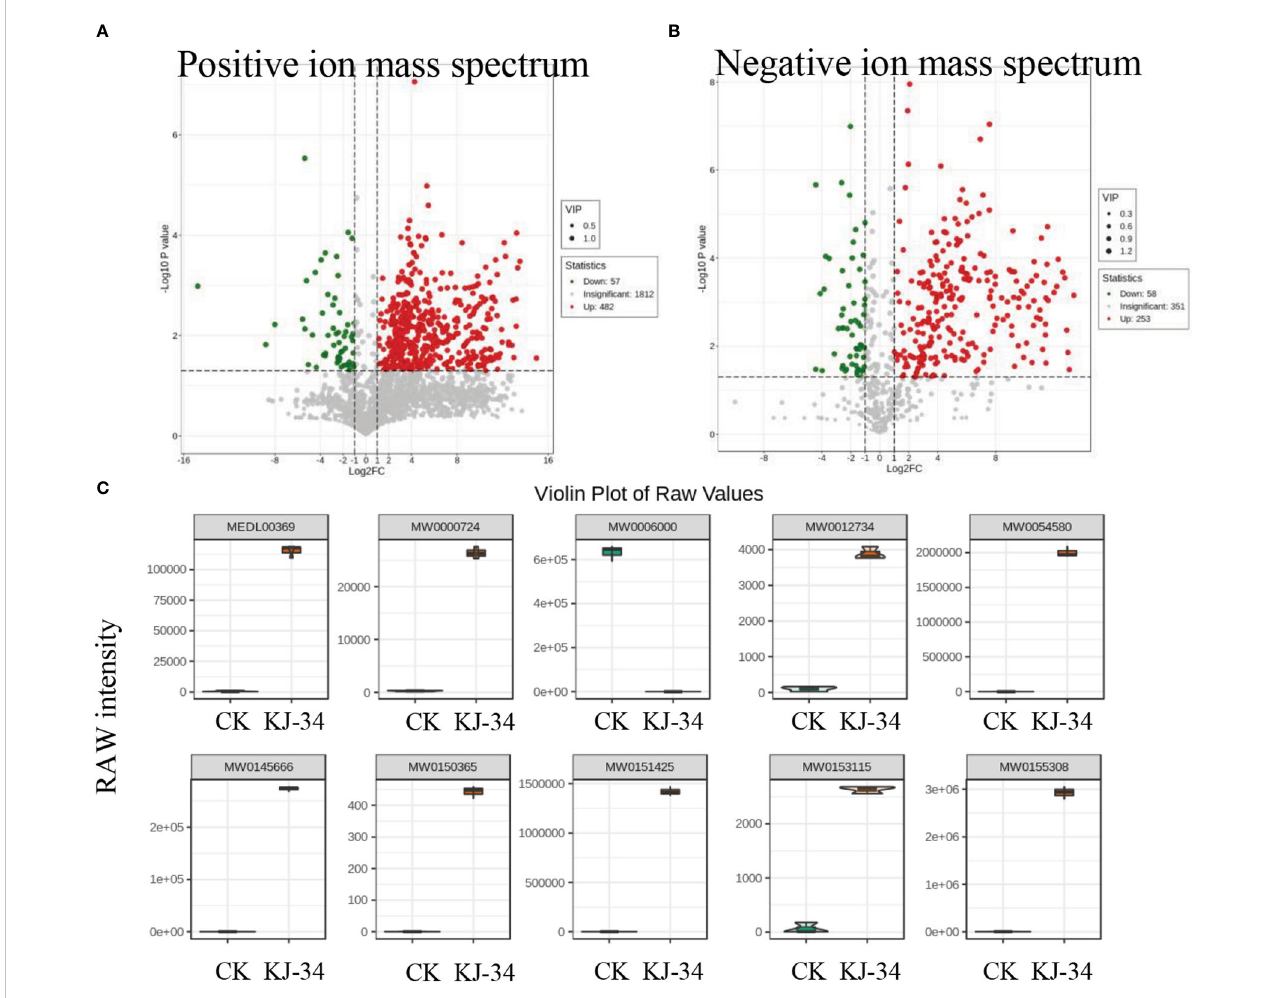
FIGURE 5 Specialized metabolites produced by KJ-34. (A, B) Volcanic map of differential metabolites. Each dot in the volcano plot represents a metabolite, with green dots representing differentially down-regulated metabolites ’ and differentially upregulated metabolites, red dots up-regulated differential metabolites, and gray metabolites detected but not signi fi cantly different. (C) Violin plot of some differential metabolites signi fi cantly enriched in KJ-34 fermentation